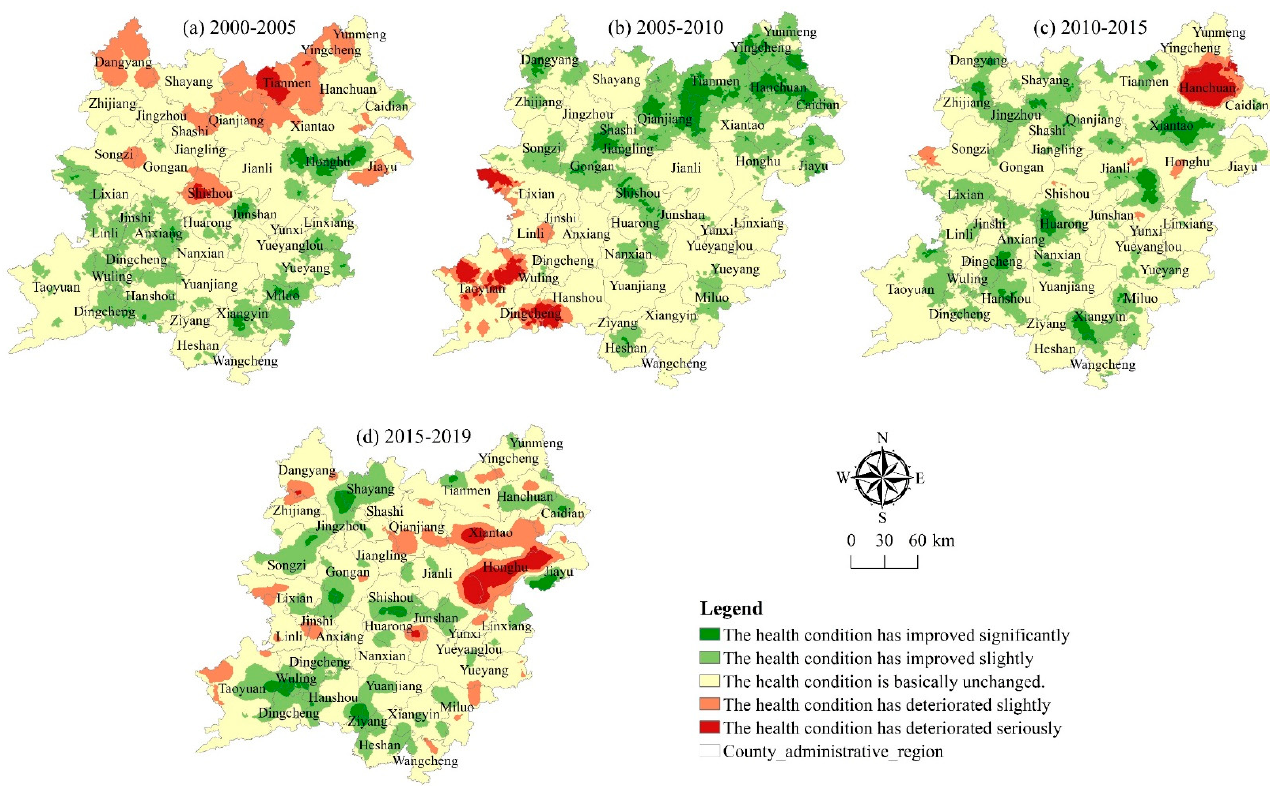
Figure 7. Change direction of cultivated land system health in the two lake plains from 2000 to 2019. Table 4. Changes in cultivated land area of different levels in the two lake plains.